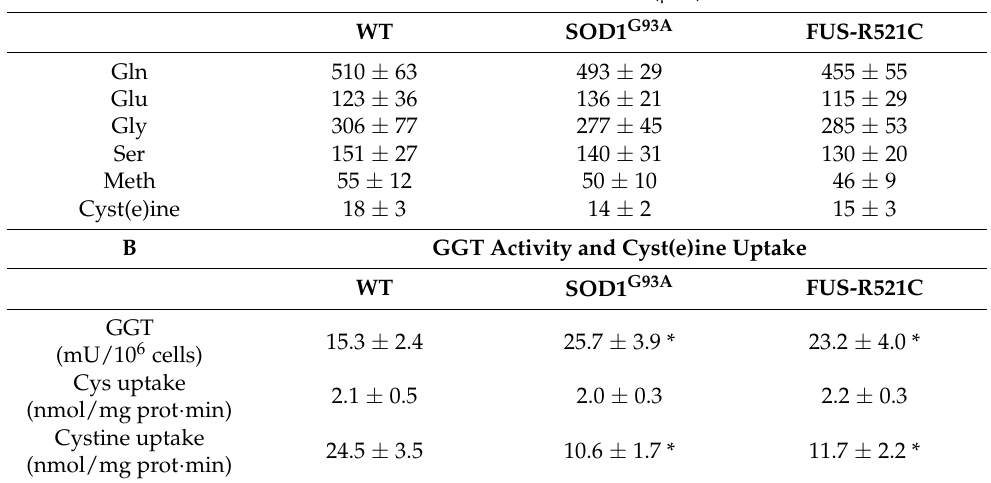
Table 6. Supply of amino-acid precursors for GSH synthesis, GGT activity and cyst(e)ine uptake in astrocytes isolated from wild-type and ALS mice at an advanced state of progression. ( A ) Amino-acid levels in circulating blood. ( B ) GGT activity and rates of Cys and cystine uptake. To measure Cys and cystine uptake, astrocytes were incubated in the presence of 0.2 µ Ci/mL of [ 35 S]Cys and 10 uM Cys or 0.5 µ Ci/mL of [ 35 S]cystine and 100 uM cystine (labeled amino acids were obtained from PerkinElmer, Waltham, MA, USA). Maximum rates of Cys and cystine uptake were reached at